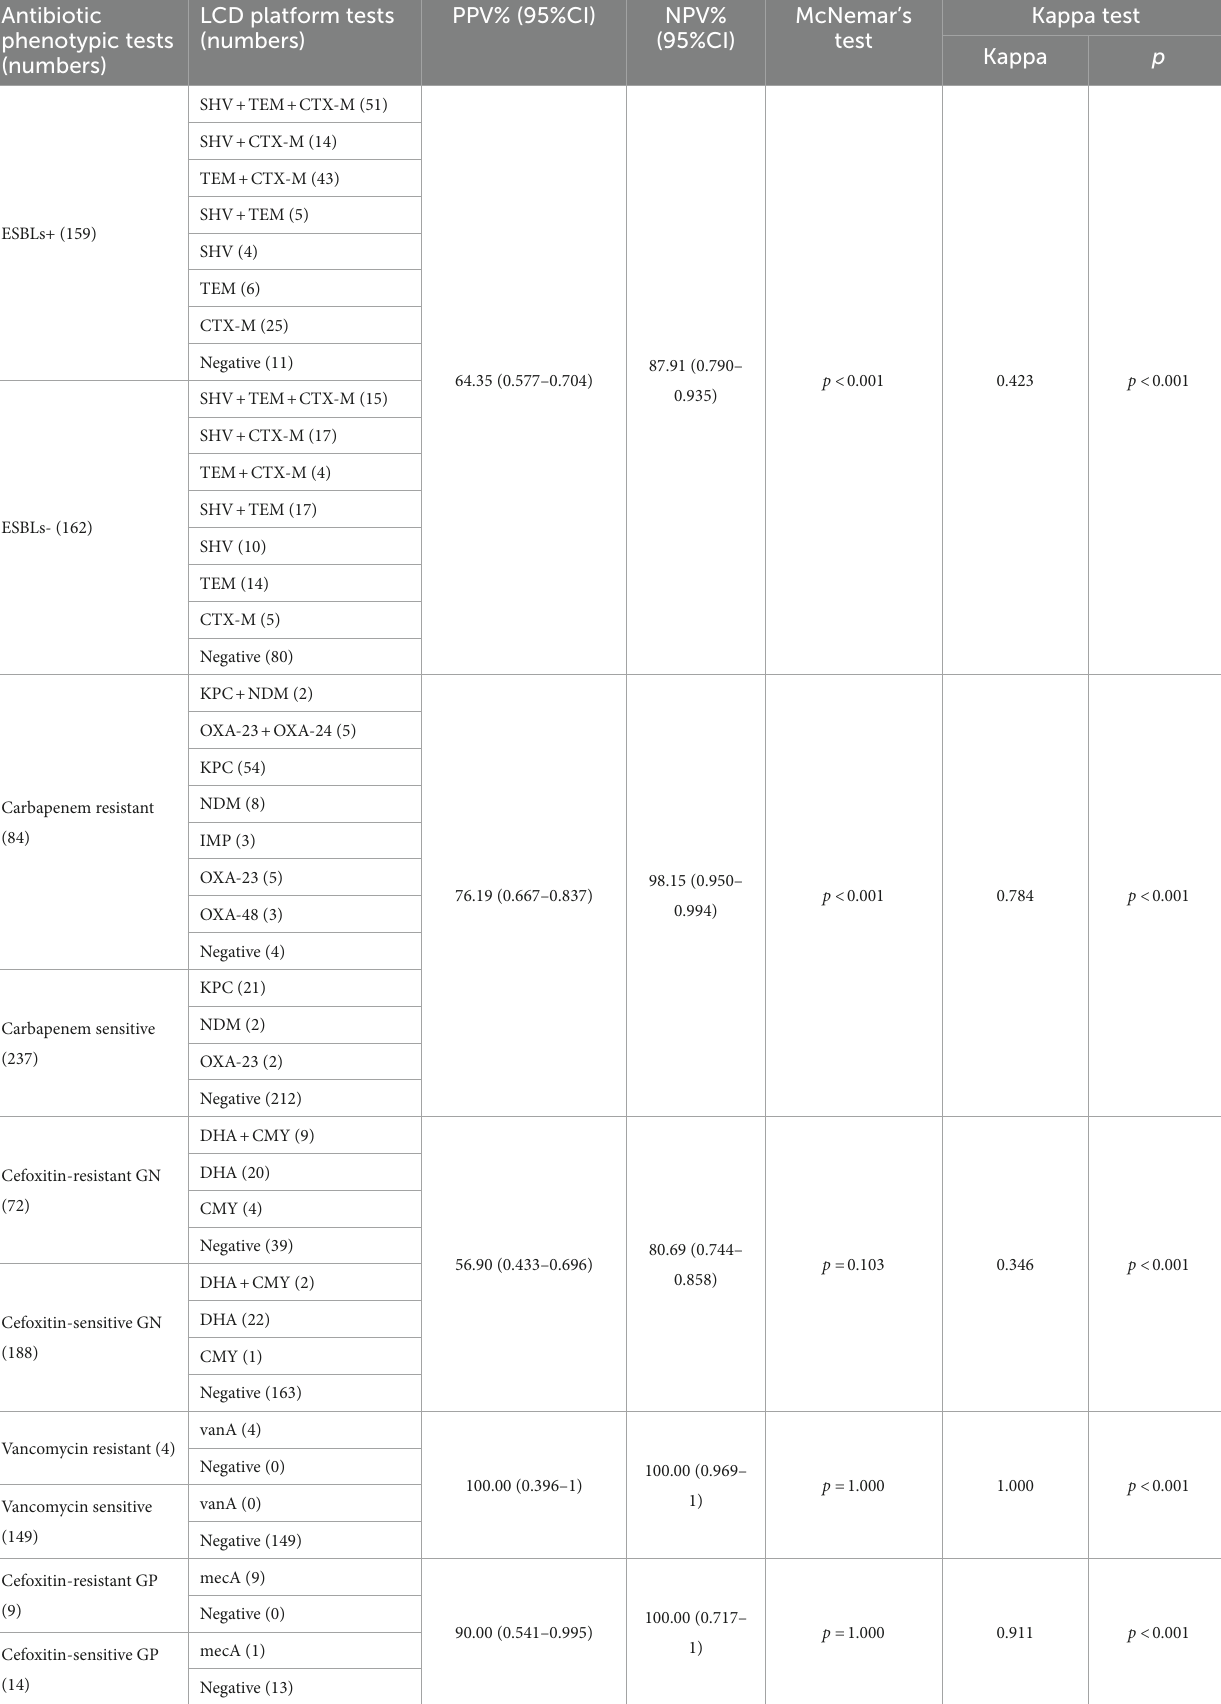
TABLE 4 Results of LCD platform were compared to results using phenotypic tests. Antibiotic phenotypic